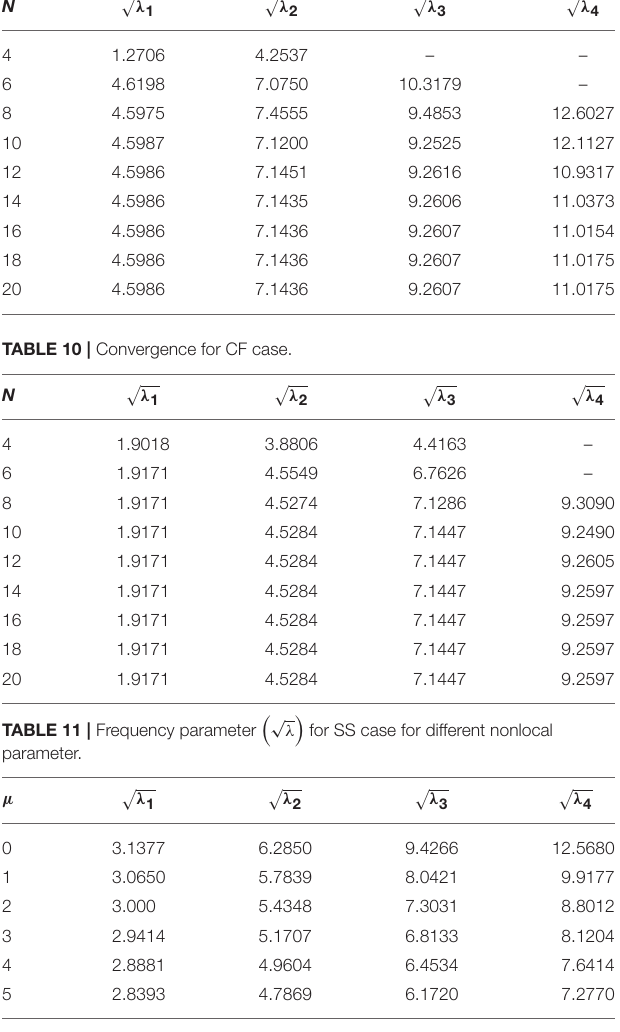
√ λ for CS case for different nonlocal (cid:16) (cid:17)